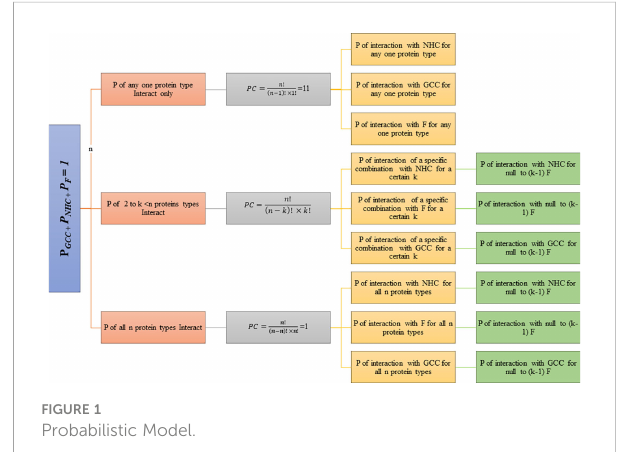
FIGURE 1 Probabilistic